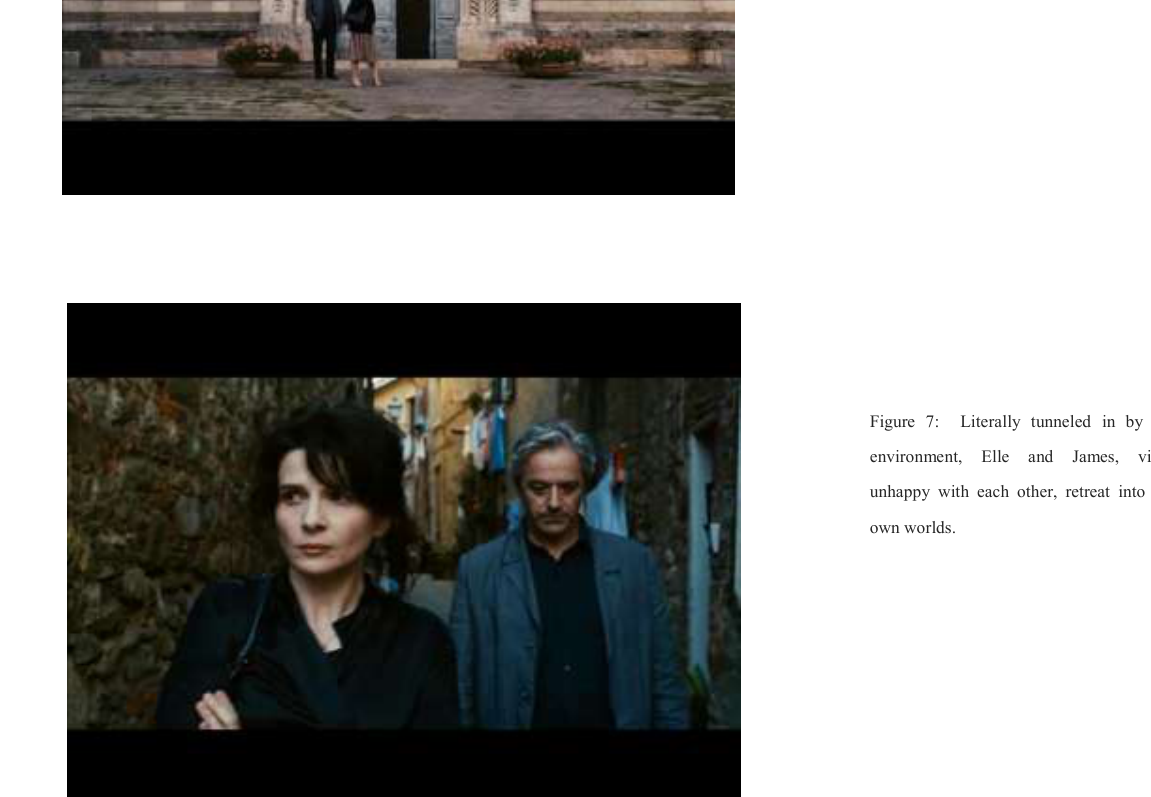
Figure 6: Here, the grandiose setting of a cathedral dwarfs the couple. Their lives and problems, from this perspective, seem small in respect to the wide world around them.